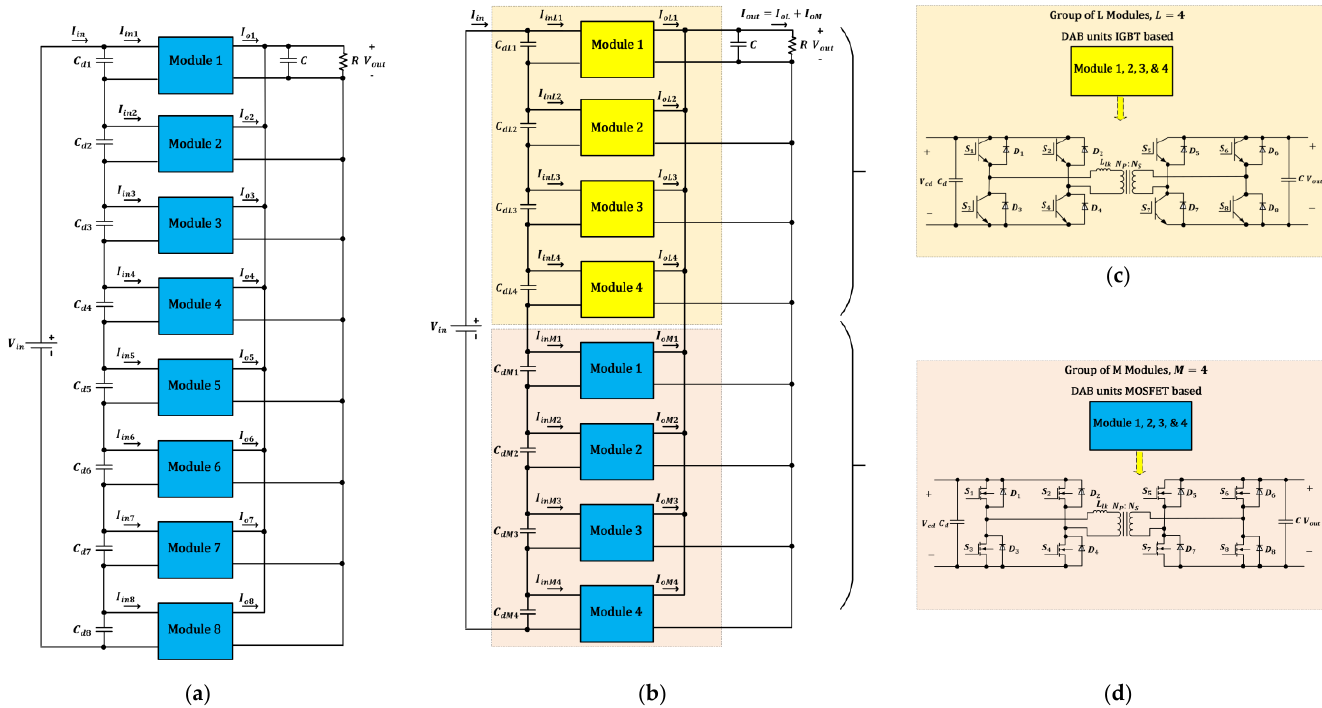
Figure 5. Eight-module ISOP multimodule DC-DC converter circuit diagram; ( a ) Conventional ISOP DC-DC Converter, ( b ) Hybrid ISOP DC-DC Converter, ( c ) DAB Converter based on IGBTs, ( d ) DAB Converter based on MOSFETs.